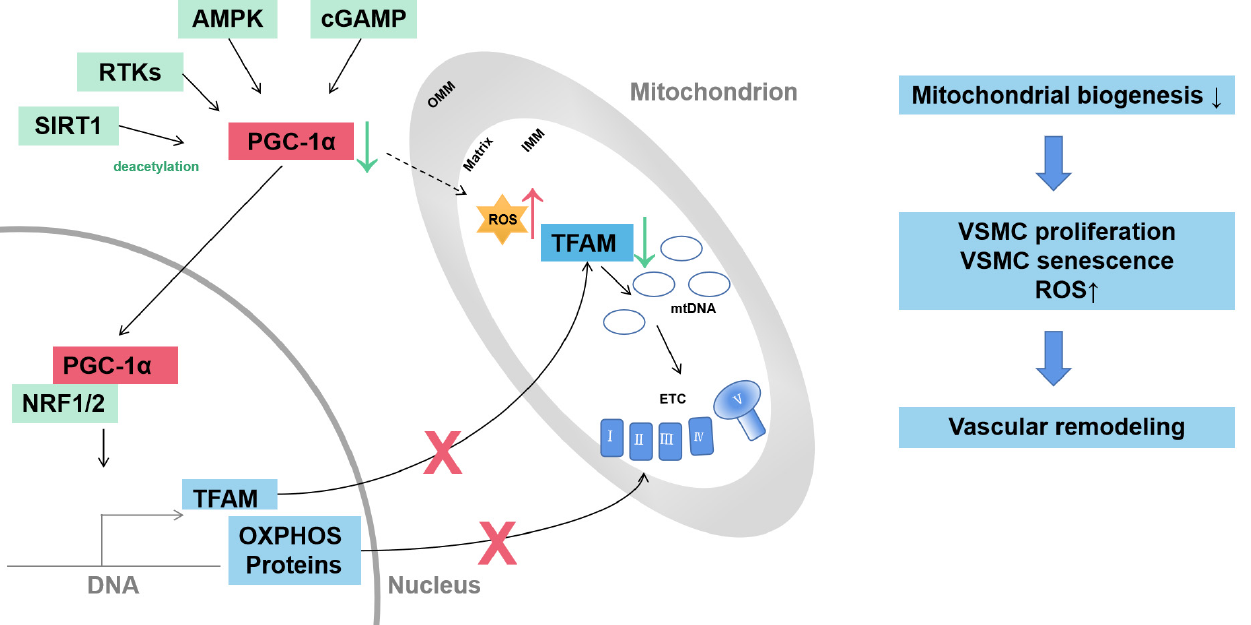
Figure 1. Mitochondrial biogenesis of VSMC in vascular remodeling. Mitochondrial biogenesis is driven by transcriptional coactivator PGC-1 α . The expression and activity of PGC-1 α are regulated through diverse pathways, including RTKs, cGMP, AMPK and SIRT1. PGC-1 α activates transcriptional factors NRF1 and NRF2 to induce transcription of TFAM and nDNA-encoded OXPHOS proteins. TFAM controls the transcription and replication of mtDNA. Decreased PGC-1 α contributes to VSMC proliferation, senescence and ROS production and drives vascular remodeling. AMPK, adenosine monophosphate-activated kinase; cGMP, cyclic guanosine monophosphate; ETC, electron transport complex; IMM, inner mitochondrial membrane, mtDNA, mitochondrial DNA; NRF1/2, nuclear respiratory factor-1/2; OMM, outer mitochondrial membrane; OXPHOS, oxidative phosphorylation; RTKs, receptor tyrosine kinases; SIRT1, sirtuin 1; TFAM, mitochondrial transcription factor A; VSMC, vascular smooth muscle